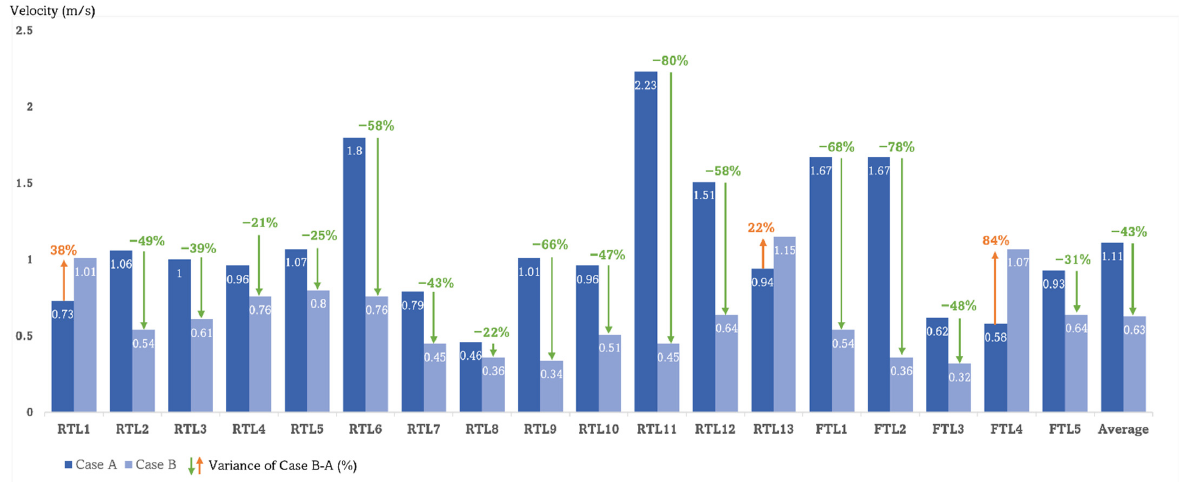
Figure 10. Wind speed of Case A & B and the variance of Case (B-A) % of each test line and the average value. Variance of Case (B-A) was calculated with the equation (cid:1829)(cid:1853)(cid:1871)(cid:1857) ((cid:1828) − (cid:1827)) = (cid:2204) (cid:2159)(cid:2183)(cid:2201)(cid:2187)(cid:2158) (cid:2879)(cid:2204)